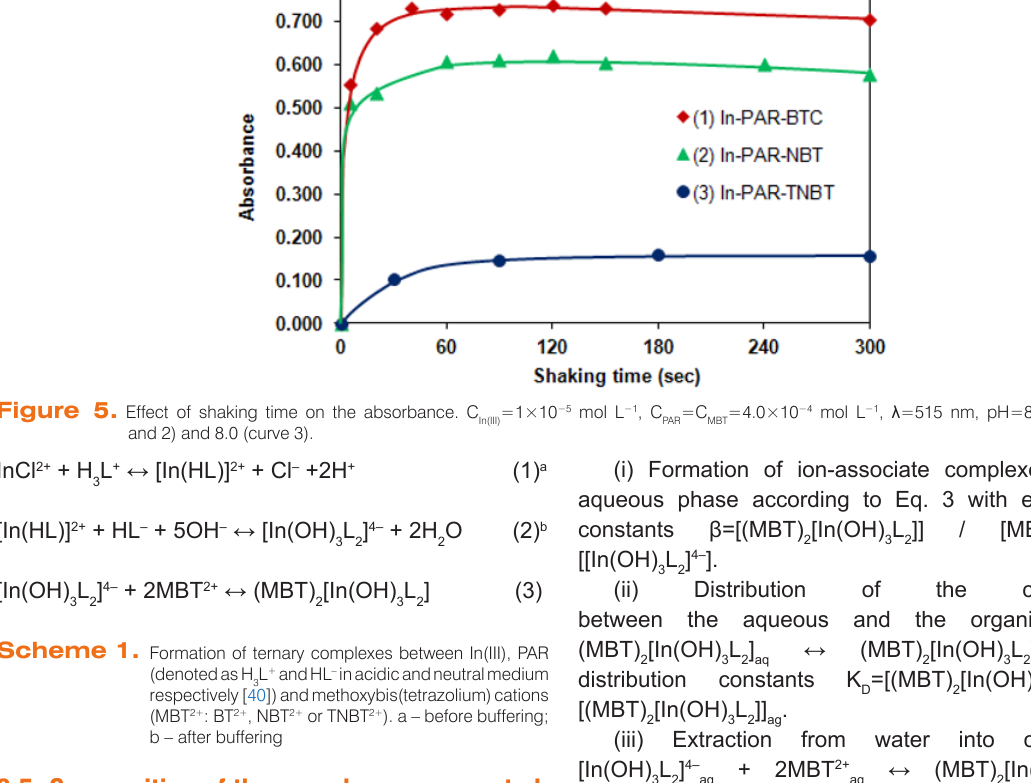
Scheme 1. Formation of ternary complexes between In(III), PAR (denoted as H L + and HL – in acidic and neutral medium 3 respectively [40]) and methoxybis(tetrazolium) cations (MBT 2+ : BT 2+ , NBT 2+ or TNBT 2+ ). a – before